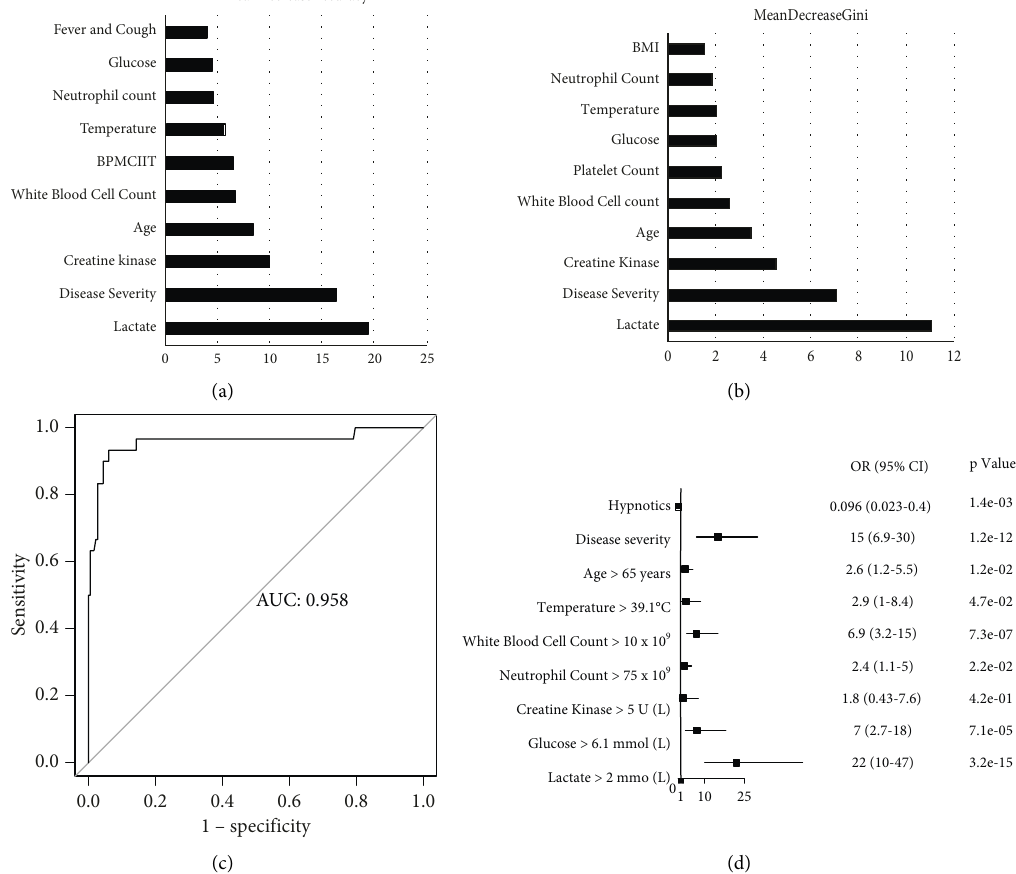
Figure 2: Prediction model and multivariate regression. (a) Mean Decrease Accuracy shows the relative degree to which a factor improves the accuracy of the forest in classification prediction. (b) Mean Decrease Gini assigns a weight of importance to each parameter, which improves accuracy of the prediction. (c) A receiver operating characteristic curve (ROC curve) based on random forest algorithm predicts COVID-19 patients develop septic shock. (d) Independent significant factors for septic shock in hazard ratio analysis based on a multivariate logistic regression model show that hypnotics (HR � 0.096, p � 0 . 0014) were the only protecting features selected by the prediction model are presented in Figure 2(d). During the admission day to day 14, white blood cell count, neutrophil count, blood urea nitrogen, and glucose were significantly increased in the septic shock group.